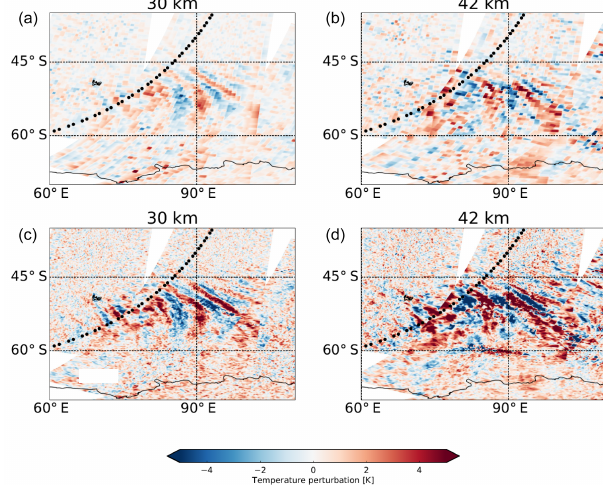
Figure 6. Same as Fig. 4 but for a non-orographic gravity wave event over the southern Indian Ocean on 8 August 2007 at about 17:00UTC.